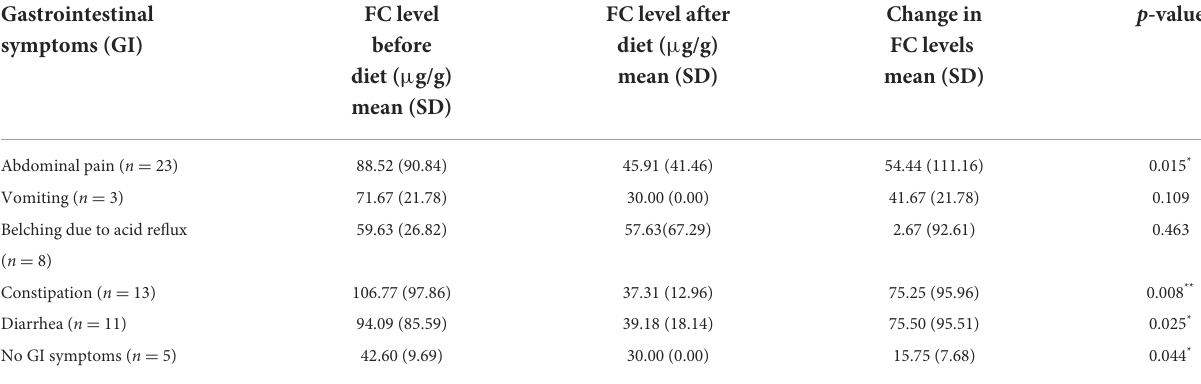
TABLE 4 Gastrointestinal symptoms, calprotectin levels and changes in calprotectin levels in children following the elimination diet ( n = 35).